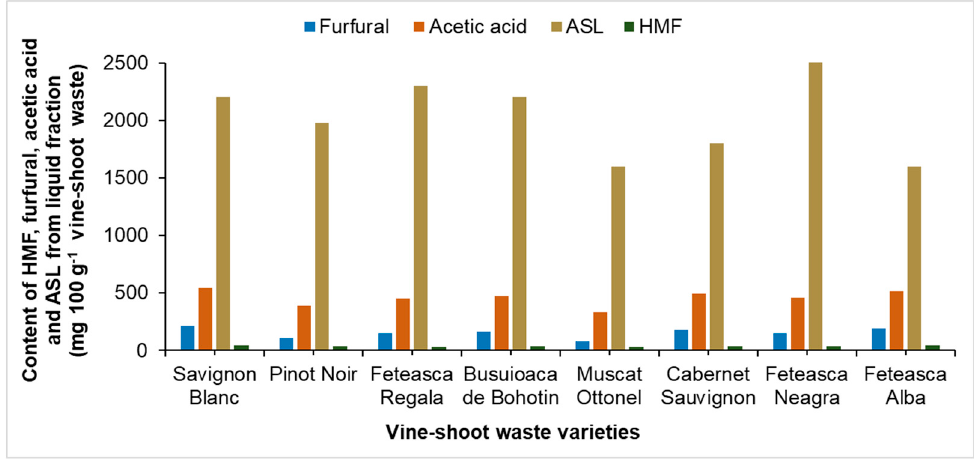
Figure 2. The content of HMF, furfural, acetic acid and ASL in the hemicellulosic fraction separated after autohydrolysis at 180 °C.